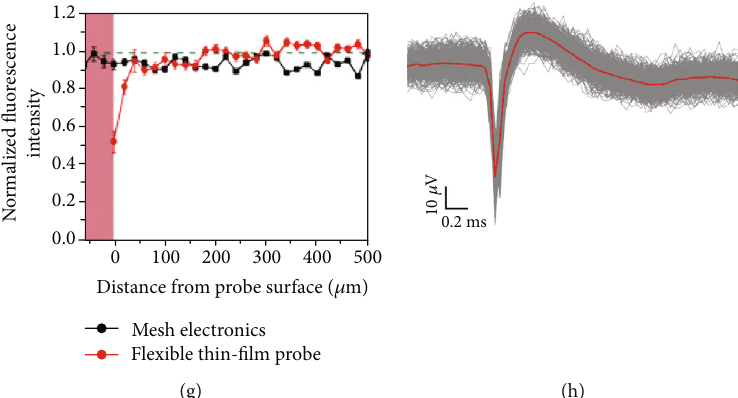
Figure 6: (a) Thin- fi lm electronics may induce the glial scar formation while the mesh electronics may not. The blue lines represent di ff erent types of electronics (mesh and thin fi lm), the neurons are in purple, and the glial scars are in yellow [94]. (b) Schematic showing a mesh electronic that is injected into the tissue and extended [95]. (c) Mesh electronics injected by the balanced FoV approach was extended (1). And a mismatched injection may result in a wrinkled mesh (2) [96]. (d) A comparison between the bending sti ff ness of the NET- structured probes and other typical fi ber-based probes [105]. (e) Stable impedance (red) and low noise level (blue) were demonstrated by the NET-structured probes during a long-term recording process ( ~ 4 months) [105]. (f) Stable average amplitude (red) and large SNR (blue) for the chronic recording of single-unit APs were also observed on the NET probes [105]. (g) Stable fl uorescence intensity of neuron somata can be obtained near the surface of the mesh electronics as compared to the fl exible thin- fi lm probes [94]. (h) Single-unit neural recording from one channel of the mesh electronics; the average potential waveform (red) showed characteristic average duration of 2 ms and peak-to-peak amplitude of 70 μ V of the single-unit APs